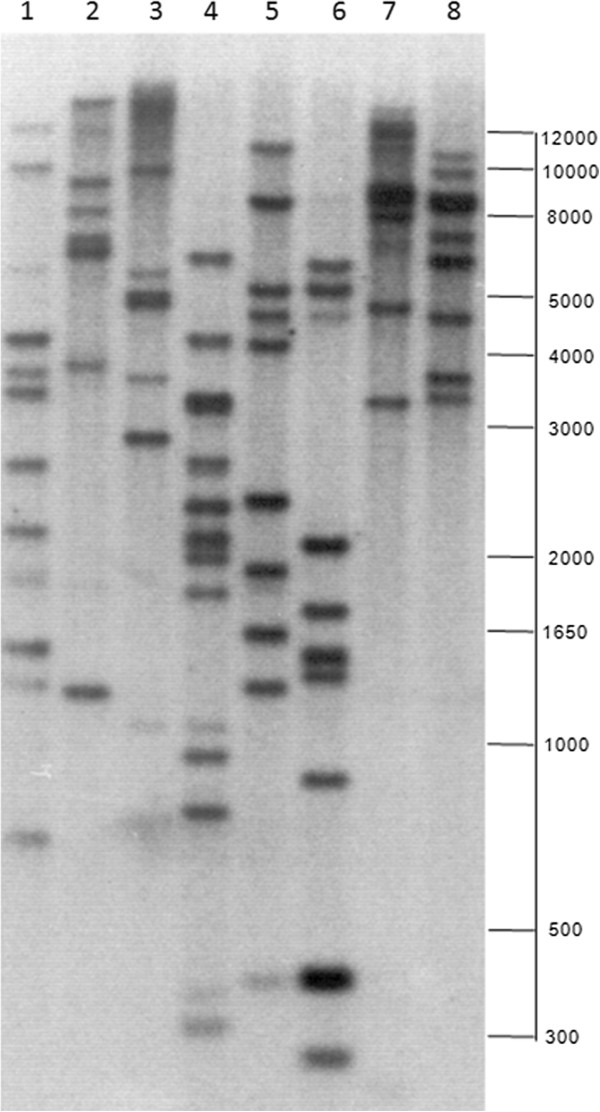
Southern blot analysis of genomic structure in safflower genotype SU. Genomic DNA samples were digested with eight different restriction enzymes prior to separation on agarose gel. These enzymes include AccI (1), BglII (2), BamHI (3), EcoRI (4), EcoRV (5), HindIII (6), XbaI (7) and XhoI (8). The blot was probed with radio-labeled entire coding region of CtFAD2-6 and washed at low stringency conditions.